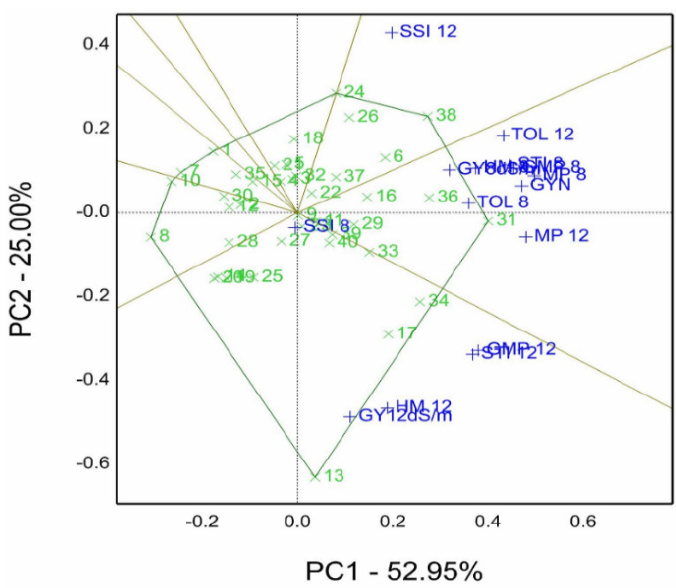
Figure 6. Which − won − where (GSTI) biplot of grain yield gm pot − 1 (GY) at control at 0.4 dS/m (GYN), grain yield gm pot − 1 at 8.0 or 12.0 dS/m (GY 8, 12.0 dS/m), and salinity tolerance/susceptible indices (calculated at control with 0.4 dS/m and 8.0 dS/m and 12.0 dS/m) of forty genotypes in the 2019/20 season. TOL, tolerance index; MP, mean productivity; STI, stress tolerance index; GMP geometric mean productivity; HM, harmonic mean; SSI, stress susceptibility index. The sum of principal components PC1 and PC2 is 79.41% of the total variation of forty genotypes combined with STI, which is represented in figures in the titled genotype by salinity tolerance indices (GSTI) biplot. The findings helped to select genotypes 31 and 36, which are pointed on the vertex of the polygon in the sector containing GSTI, such as grain yield gm per pot of normal treatment (GYN), TOL8 (for 8.0 dS/m), TOL12 (for 12.0 dS/m), MP8, STI8, GMP8, MP12, STI12, HM8, and GY8. Additionally, genotype 13 is the winner of GY12, HM12, and GMP12 in its sector, but genotypes 24 and 26 situated in the sector had SSI8 and SSI12 as sensitive